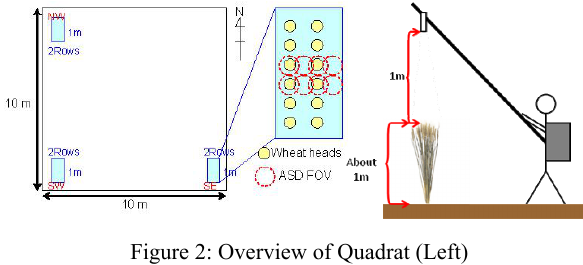
Figure 2: Overview of Quadrat (Left) and Acquisition Method (Right)